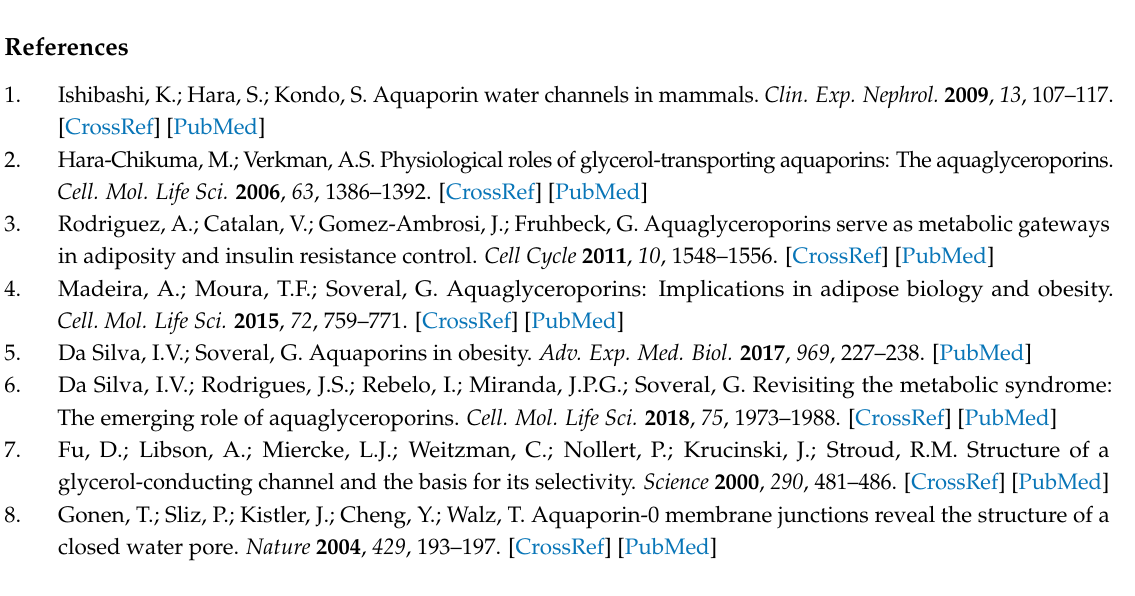
Figure S1: Localization of GFP-tagged hAQP7 expressed in S. cerevisiae aqy-null strain, Figure S2: Activation energy ( E a ) for water and glycerol permeation at distinct pH values, Figure S3: Pore size of AQP7 monomers at pH 5.0 and pH 7.0, Figure S4: Extracellular and intracellular views of the homology model of human AQP7, Figure S5: Electrostatic surfaces of hAQP7 WT and mutants, at pH 5.0 and 7.0, Figure S6: Sequence alignment of hAQP7 WT and mutants, Table S1: Human AQP7 specific primers for PCR amplification and mutagenic primers used in this study, Table S2: pH-dependency (p K a values) of water and glycerol permeation of human AQP7 (wild-type and mutated), Video S1: Permeation of glycerol via hAQP7, embedded in a lipid bilayer, at pH 7.0,